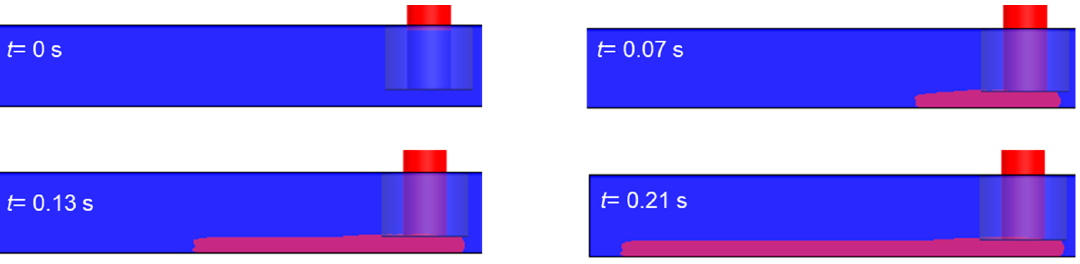
Figure 5. The distributions of a velocity component: ( Top ) the x-component of u , u x , in the strand flow from our simulation and ( Bottom ) the z-components of u , u z , inside the nozzle, evaluated from Newtonian model, analytical calculation of Equation (3), and our simulation The dash lines in each offset image show the location where the velocity component distributions were obtained.